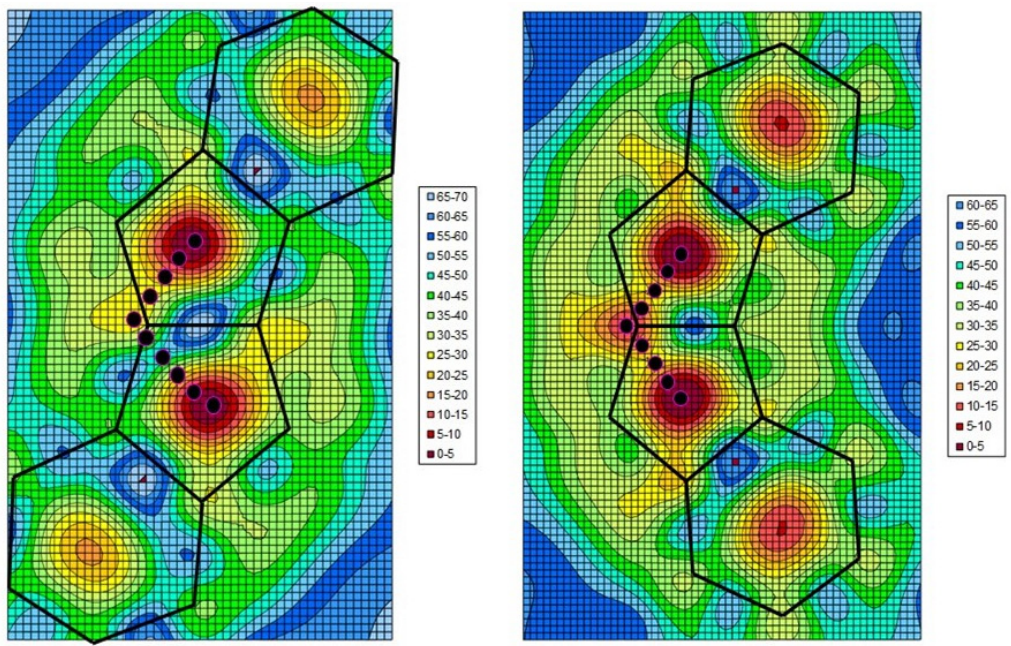
Figure 7. ( Left ) Potential energy hypersurface for the migration of an [Fe(C 5 H 5 )] + fragment over the dianion of the anti -dibenzpentalene framework, 34 . Contour lines are incremented in units of 5 kcal mol − 1 , and the favoured reaction path is superimposed as a dotted line. ( Right ) As above, for the syn -dibenzpentalene system, 33 .